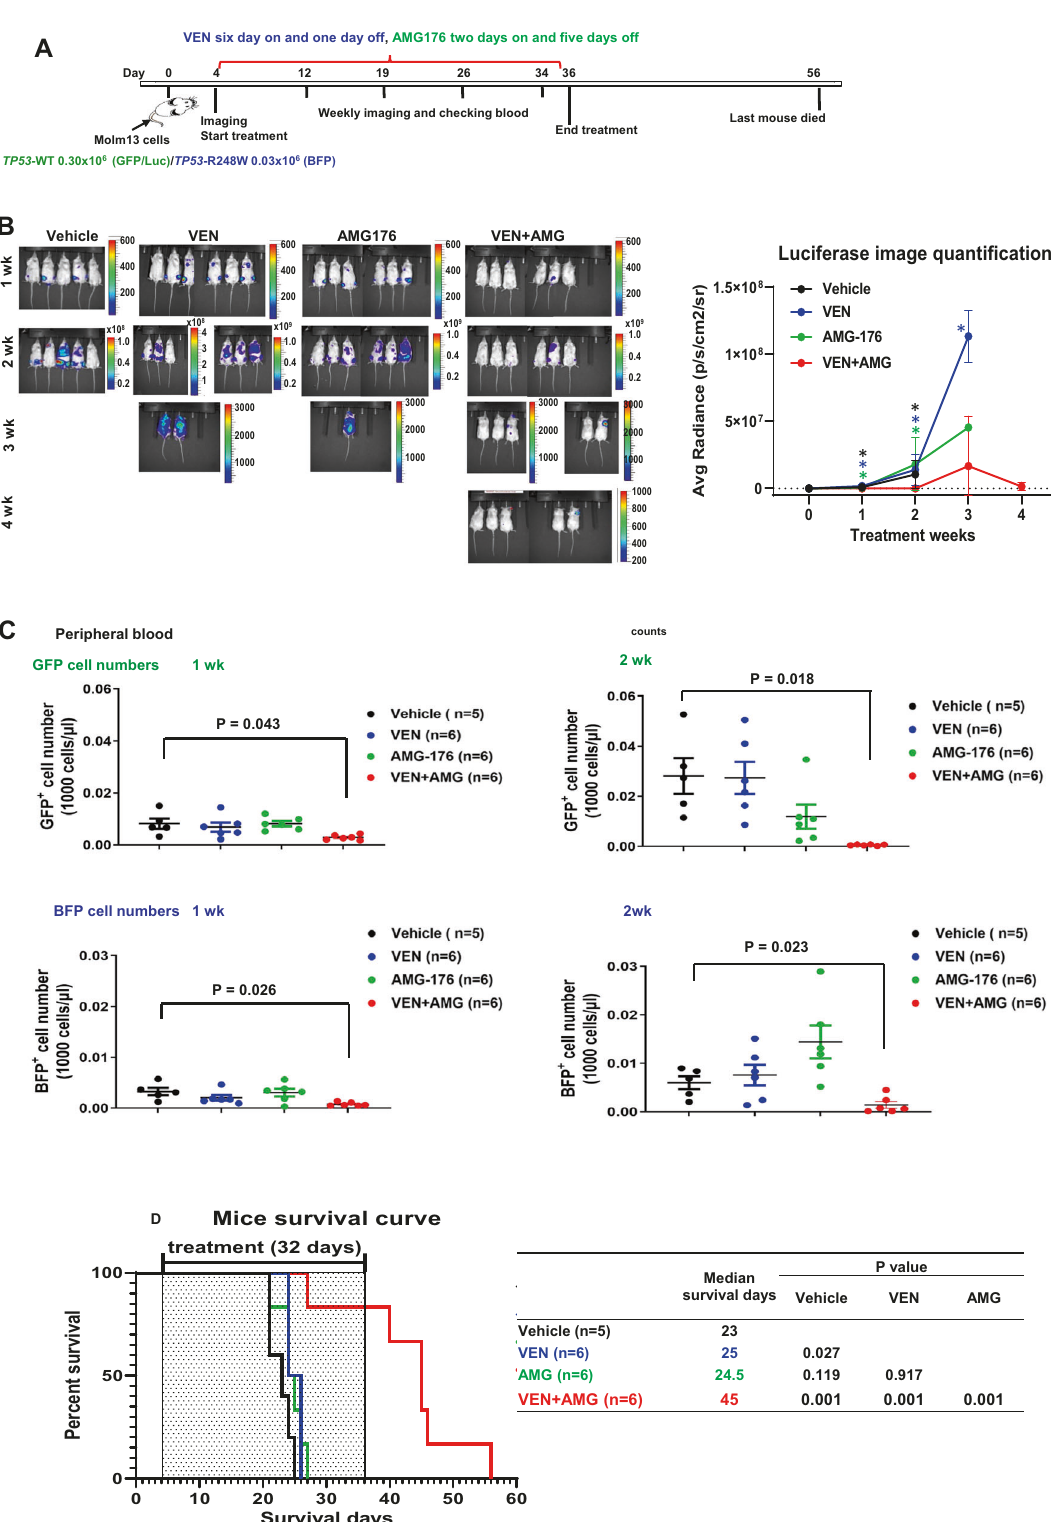
Fig. 6 The combined inhibition of BCL-2 and MCL-1 exhibits stronger in vivo anti-leukemia activity in a xenograft mouse model. A Experimental scheme. B Bioluminescence imaging and quanti fi cation. C Circulating numbers of GFP + and BFP + cells after week 1 (left) and week 2 (right) of treatment as determined by fl ow cytometry. D Survival. n = 5 or 6/group. AMG AMG176, wk week. Error bars represent the mean ± SD of data from individual